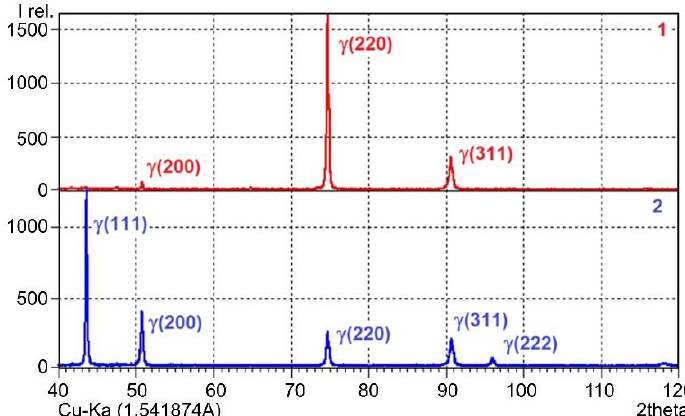
Figure 10. X-ray diffraction patterns for the steel samples after plasma deposition welding without layer-by-layer peening ( line 1 ) and with layer-by-layer peening ( line 2